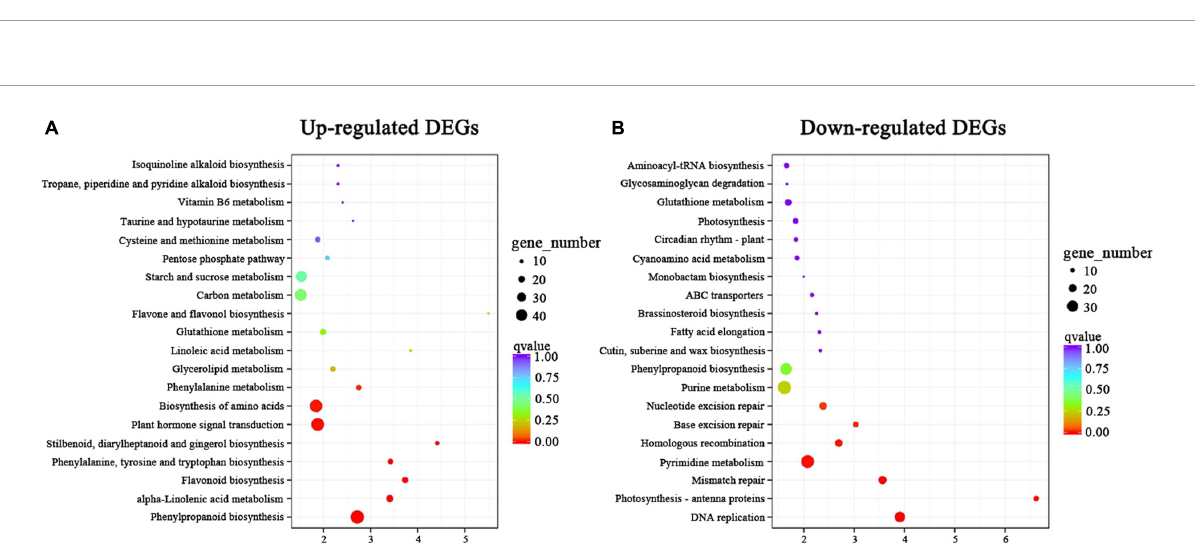
FIGURE5 KEGG enrichment analysis of DEGs in Trp + S + MeJA-treated and non-treated PLBs of D. officinale . (A) KEGG enrichment analysis of upregulated DEGs. (B) KEGG enrichment analysis of downregulated DEGs. The y -axis and x -axis represent the KEGG pathways and the enrichment factors, respectively. The greater the enrichment factor is, the more obvious the enrichment level of DEGs in the pathway. The color of the block represents the q -value, and the q -value is the p- value corrected by multiple hypothesis tests. The smaller the q -value is, the more reliable the enrichment of DEGs in this pathway is. The size of the circle indicates the number of genes enriched in the